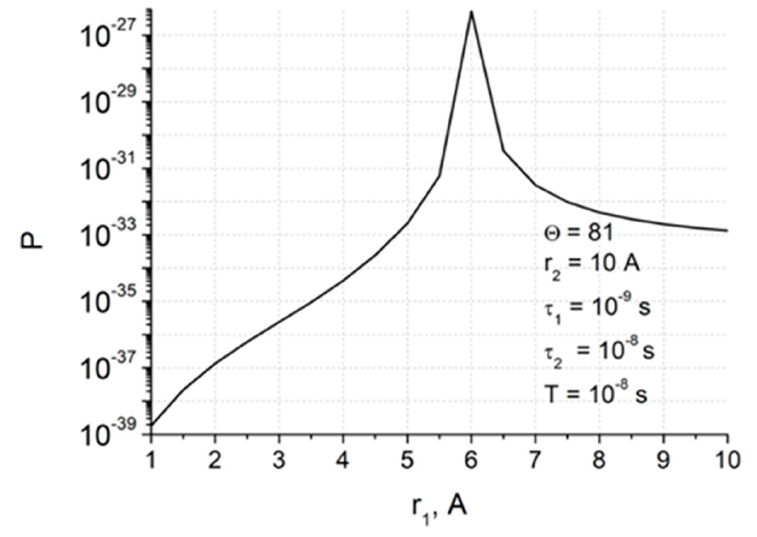
Figure 9. Dependence of hyperpolarization (P) on the distance between paramagnetic centers in the reaction zone.